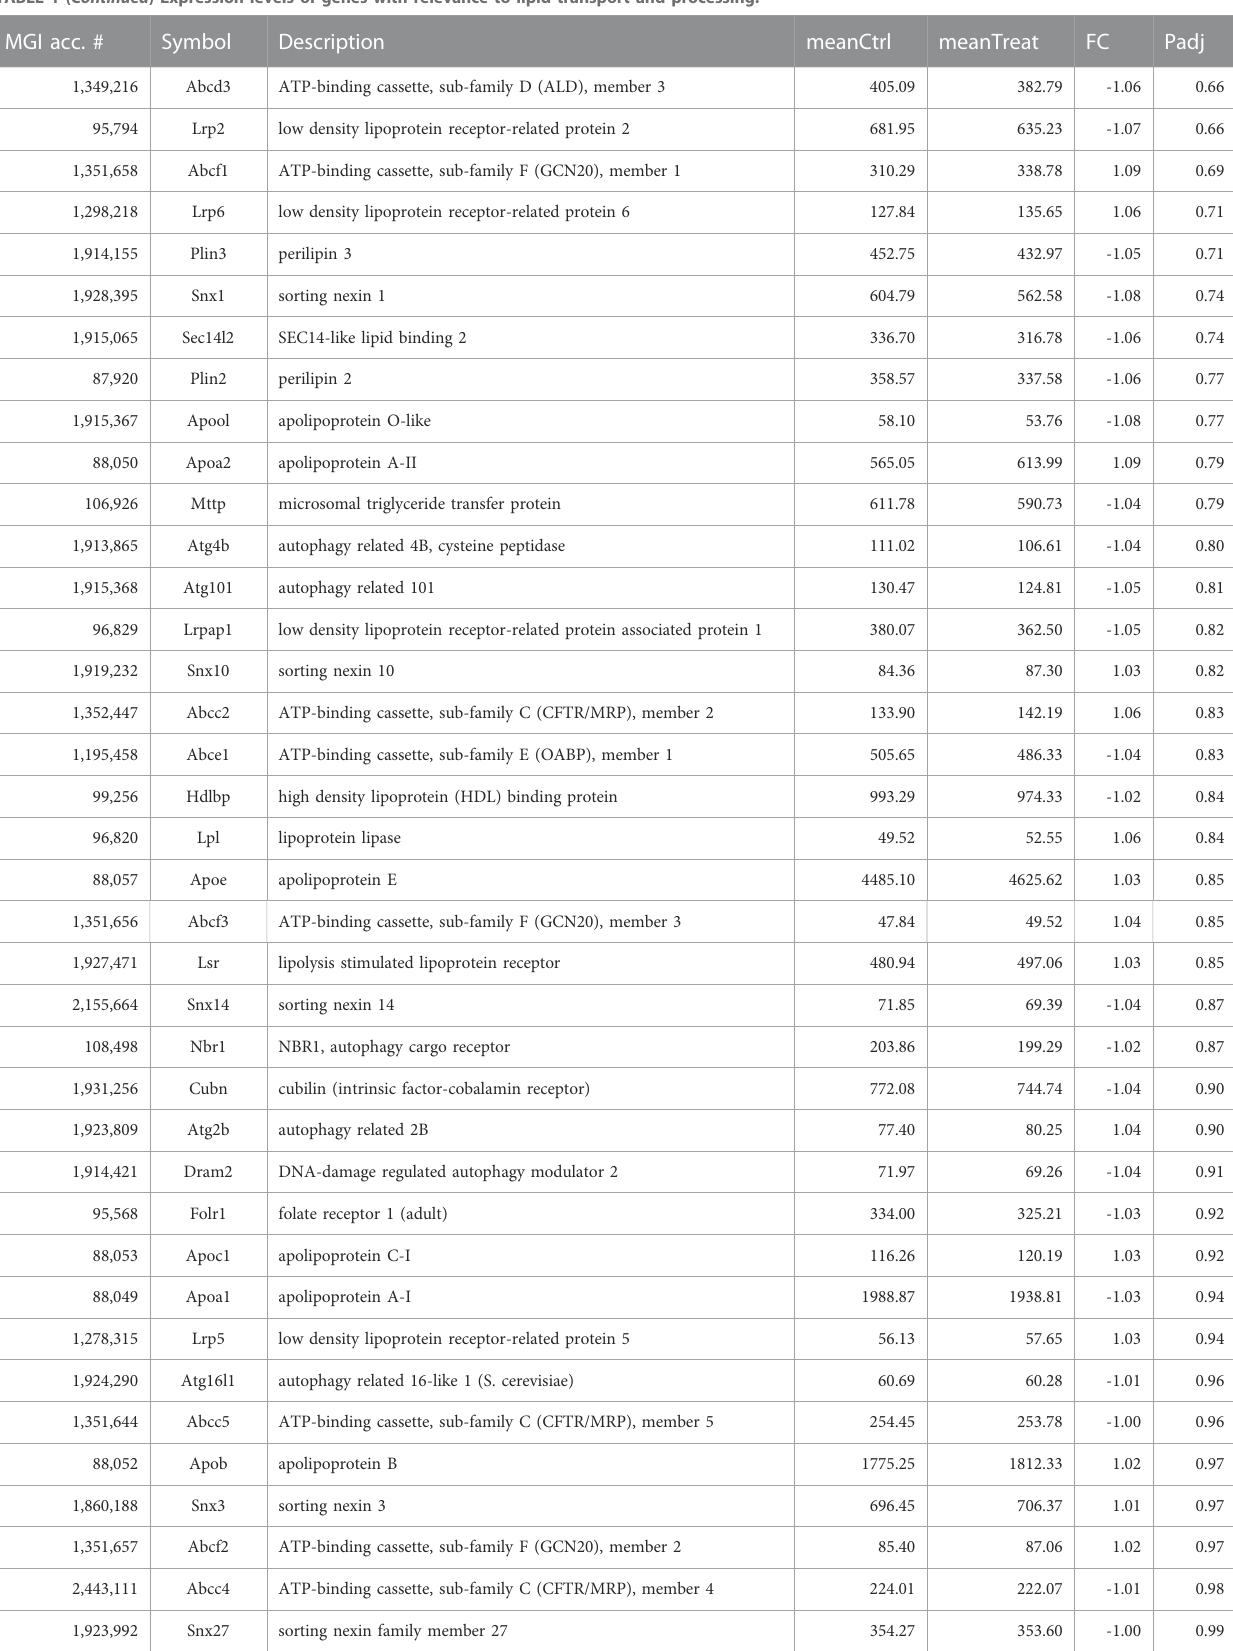
TABLE 1 ( Continued ) Expression levels of genes with relevance to lipid transport and processing. MGI acc.